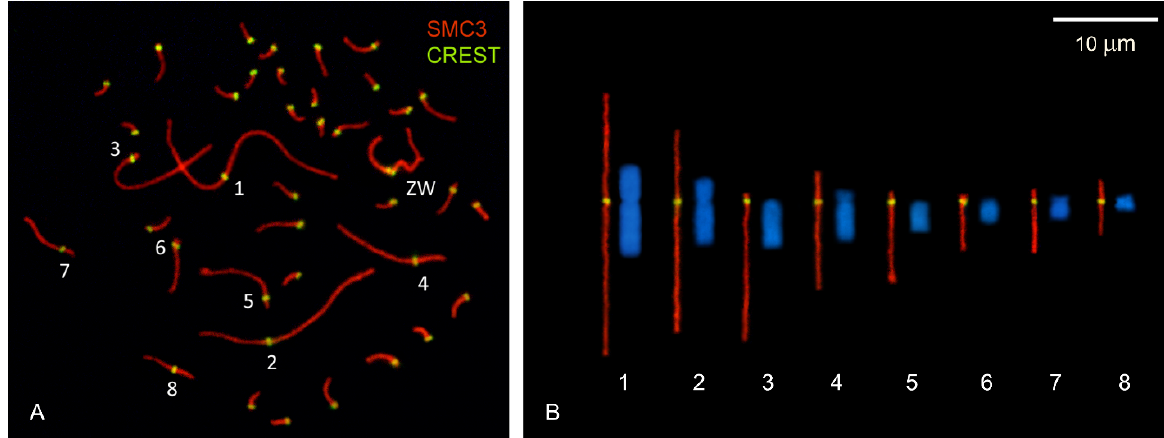
Figure 1. Mitotic chromosomes and synaptonemal complexes (SCs) in the chicken. ( A ) Surface spread of a pachytene oocyte. The SCs are labeled in red using an antibody against the cohesin SMC3. The centromeres were localized using human CREST serum and detected in green. The numbers next to the centromere signals mark the eight largest bivalents, which can be identify by their relative lengths and the centromere position. ( B ) Comparison of the mitotic macrochromosomes of the chicken with their respective SCs. The first eight autosomal SCs of the oocyte in ( A ) were digitally straightened to show the morphological correlation with the mitotic chromosomes. Bar: 10 μ m.